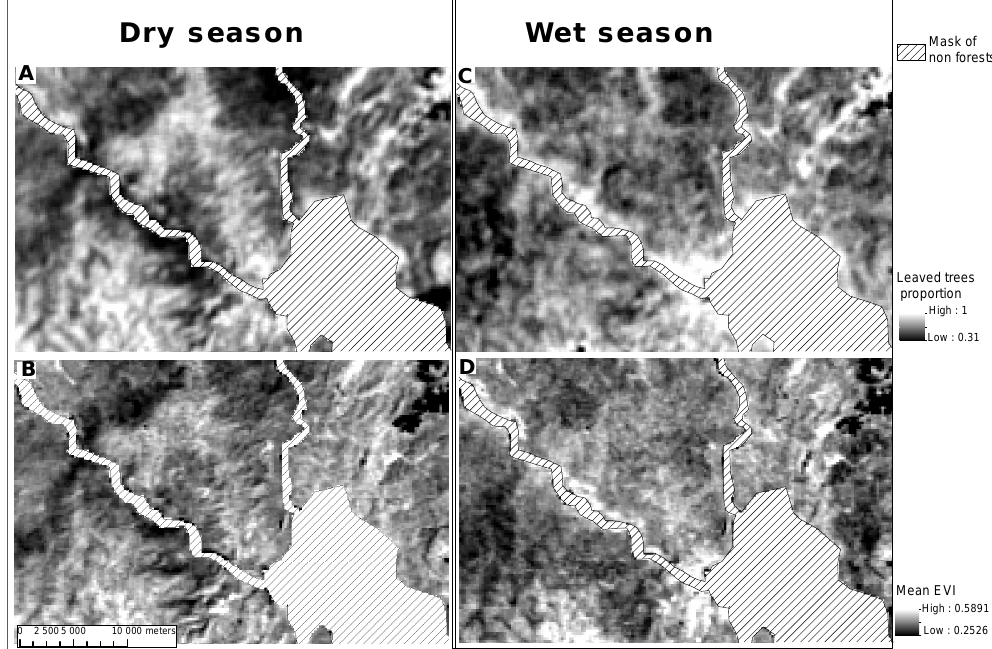
Fig. 3. Maps of the proportion of fully- or partially leaved trees vs. mean EVI values averaged for either the dry or the wet season. ( A and B ): maps of the proportion of leaved trees (A) and mean EVI values averaged (B) for dry season. ( B and D ): maps of the proportion of leaved trees (C) and mean EVI values averaged (D) for wet season. Masked areas are